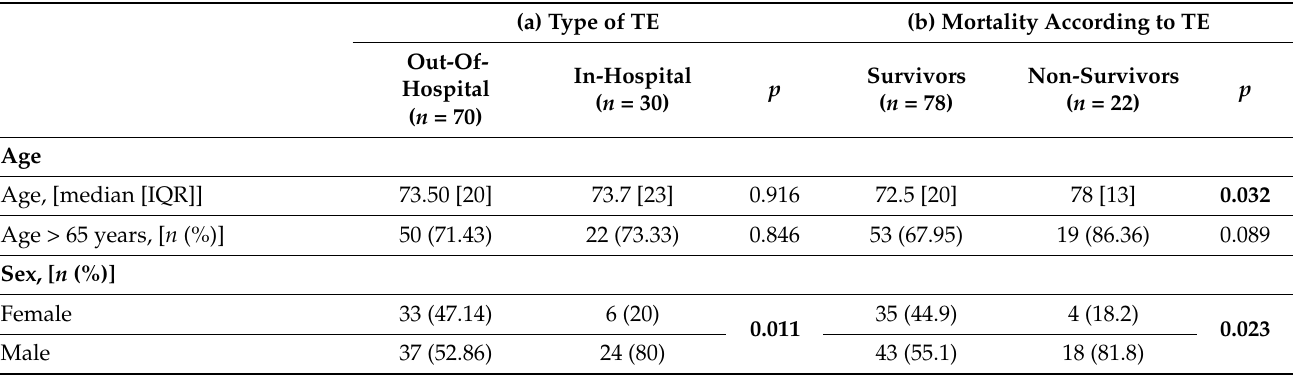
Table 2. (a): Clinical characteristics comparing out-of-hospital thrombotic events (diagnosis at hospital admission) and in-hospital thrombotic events (in-hospital diagnosis). (b) Differences in terms of mortality according to the presence of thrombotic